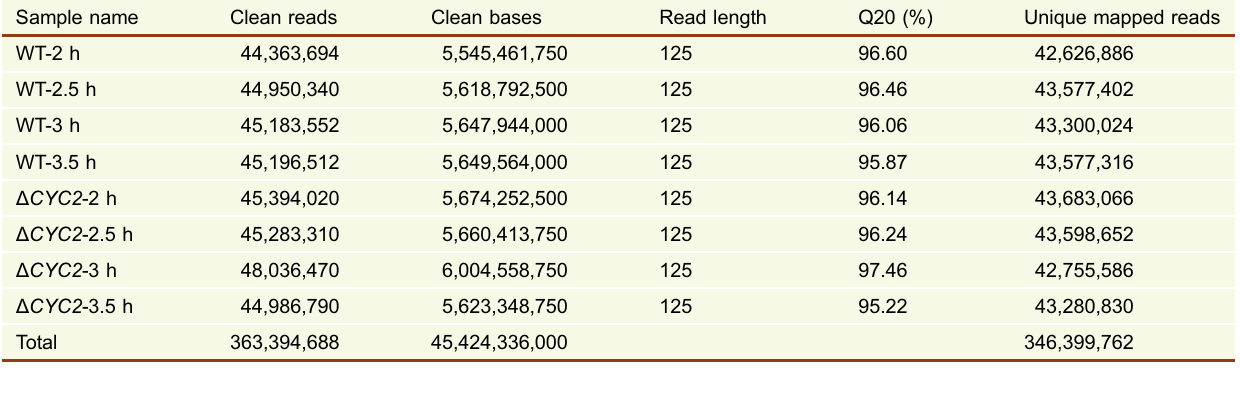
Table 1. Statistics of RNA-seq